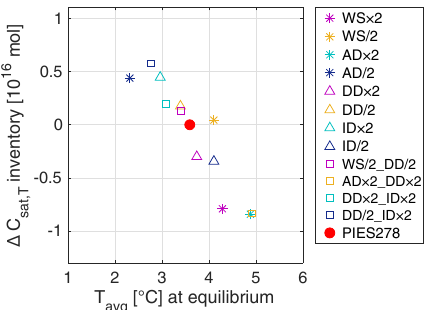
Figure 6. Global ocean average temperature ( T avg ) and the changes in TC that are due to solubility changing with temperature ( (cid:49)C sat ,T ) for the ensemble members SE1–SE12 compared to the control simulation PIES278 (red